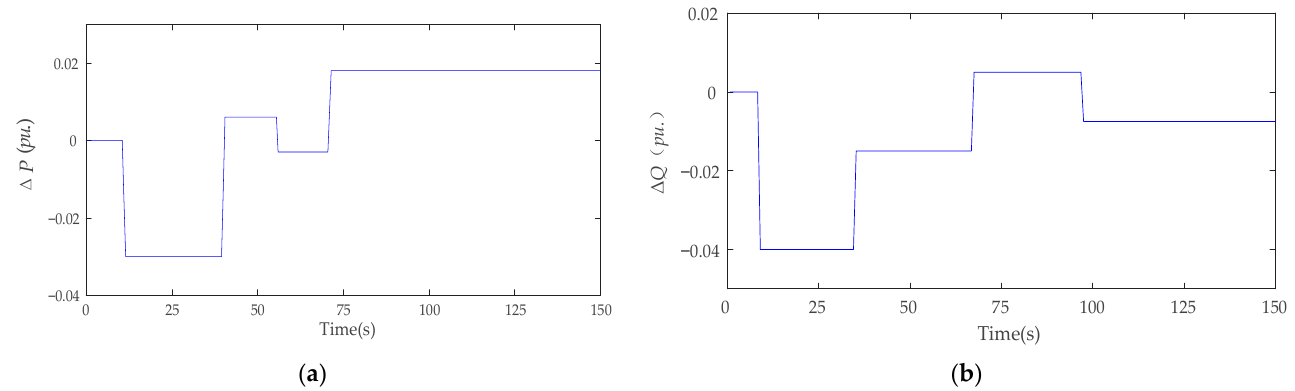
Figure 15. Load power disturbance: ( a ) load active power disturbance; ( b ) load reactive power disturbance.